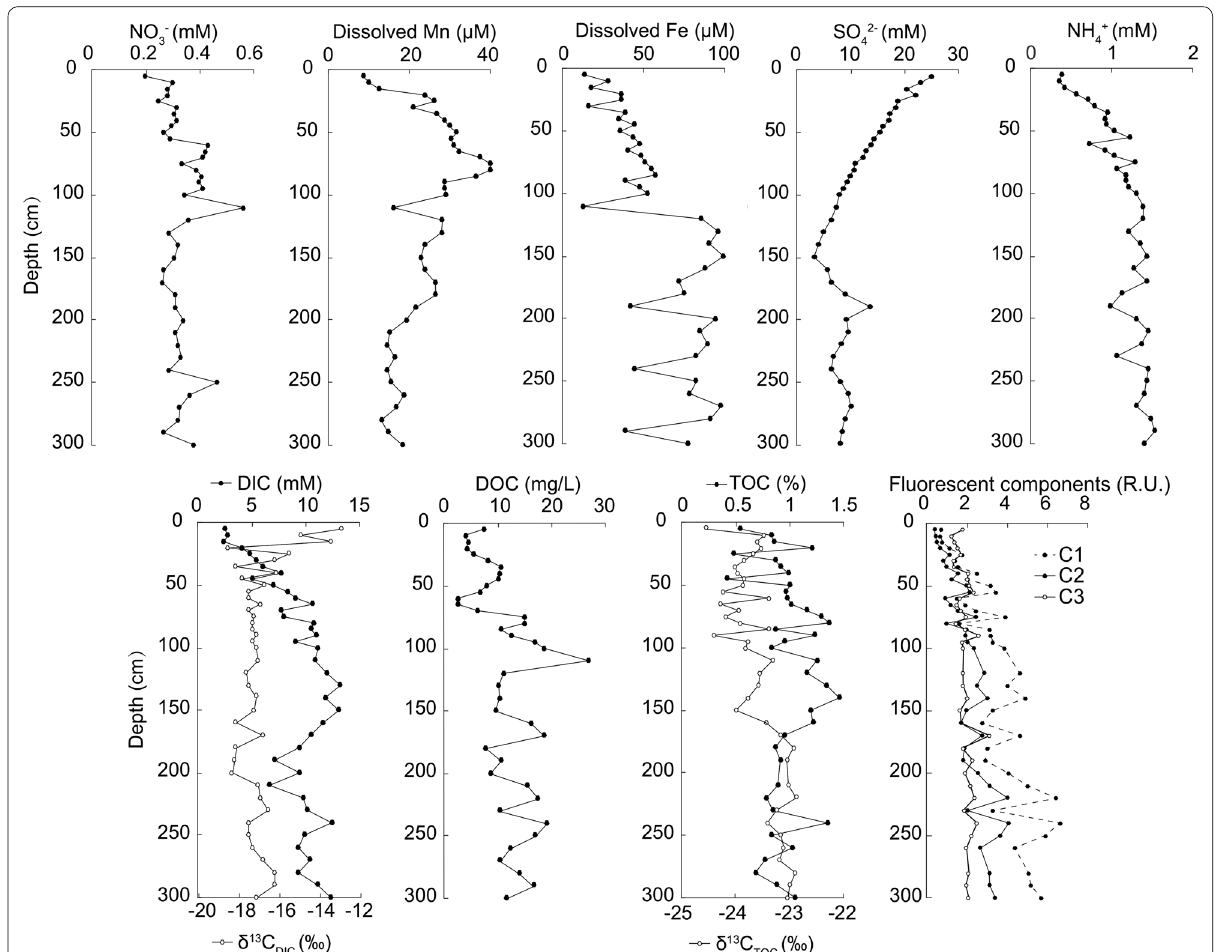
Fig. 1 Characteristics of pore water chemistry (NO 3 − , NH 4 + , dissolved Mn, Fe, and SO 42 − , DIC, DOC, and fluorescent components) and sediment total organic carbon (TOC). Collection of pore water for geochemical analyses was conducted onboard the ship as quickly as possible using Rhizon